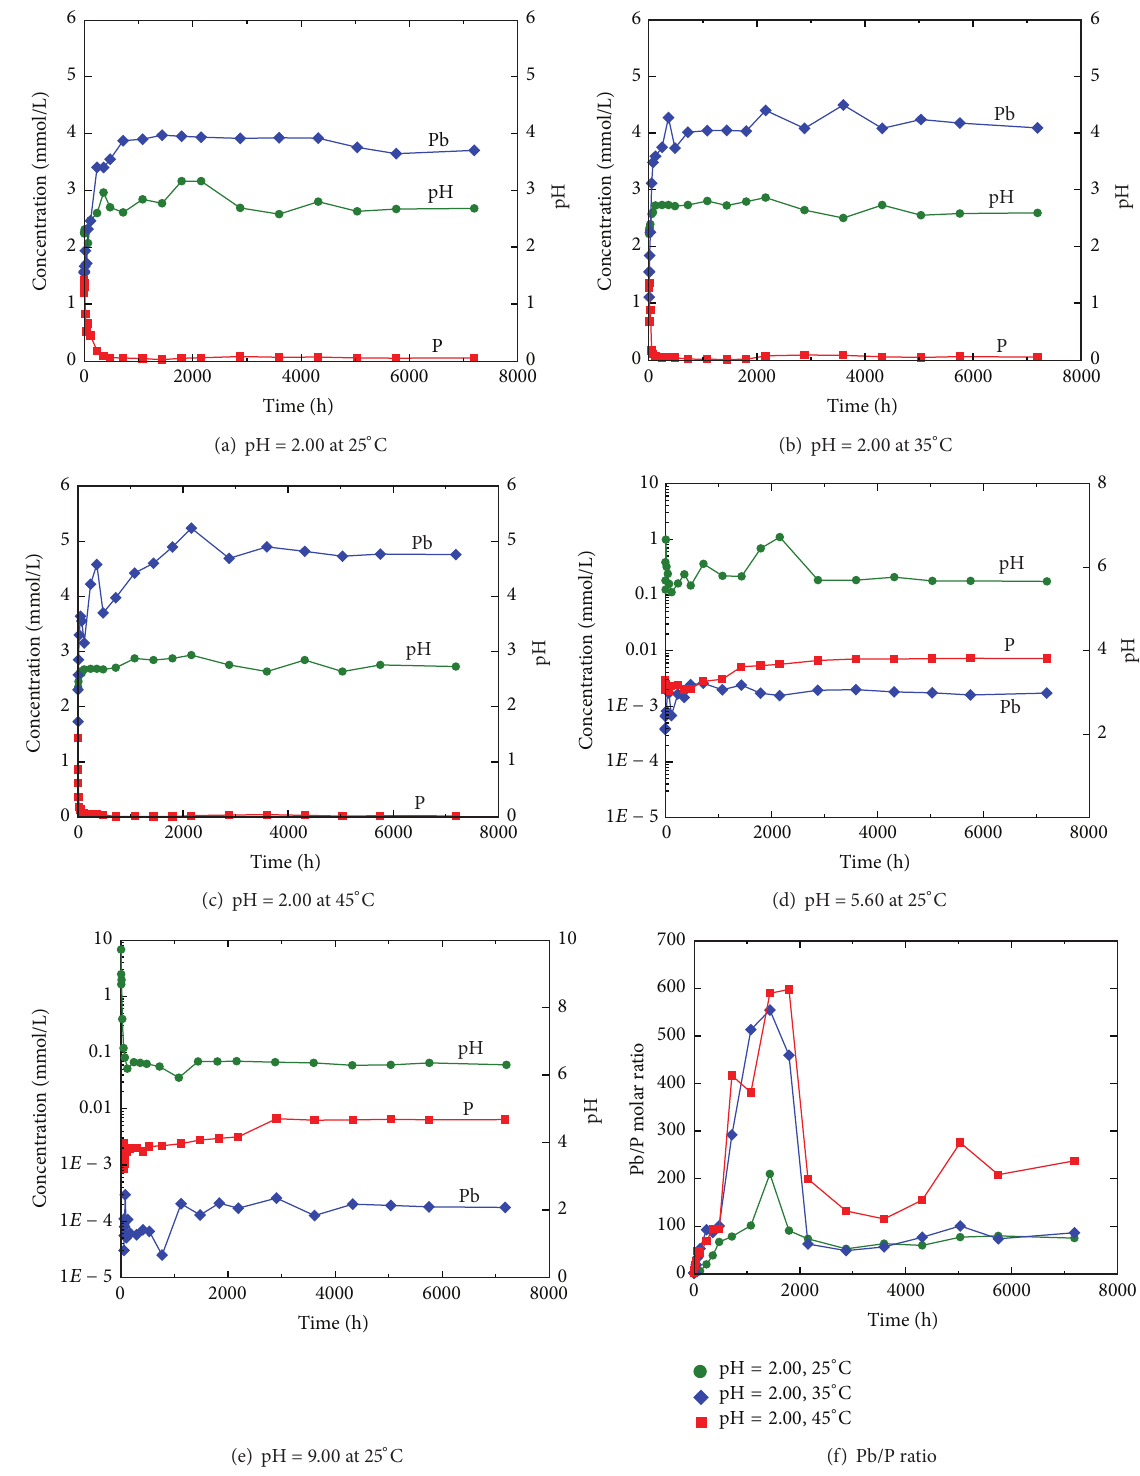
Figure 4: Aqueous evolution during the dissolution of the synthetic lead hydroxypyromorphite [Pb 5 (PO 4 ) 3 OH] at 25–45 ∘ C for 300